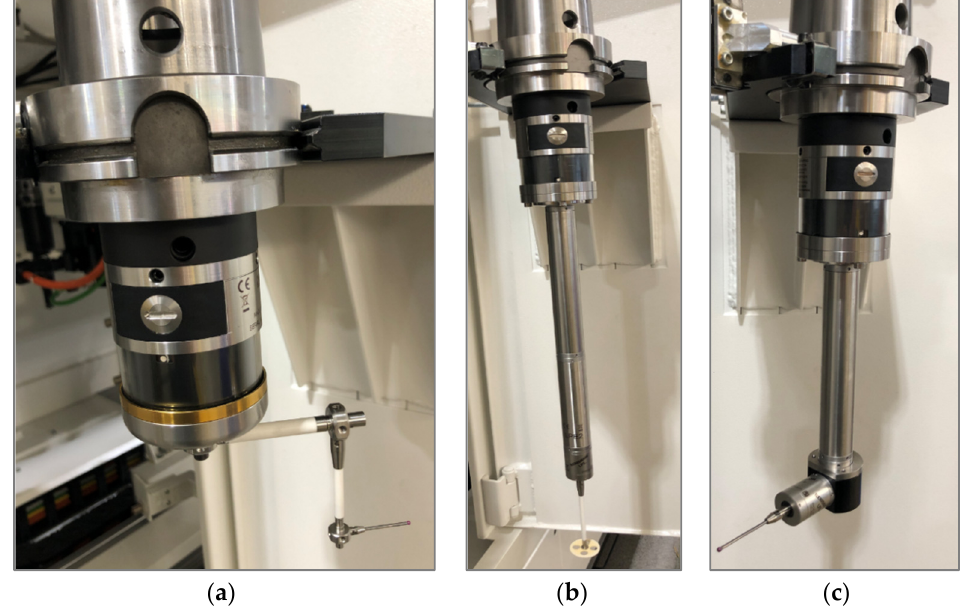
Figure 5. Configuration of TTP: special RMP600 and RMP60M + LP2 strain gauge probe. Detailed data shown in Table 2. ( a ) T4A/B probe, ( b ) T5 probe, ( c ) T6 probe.